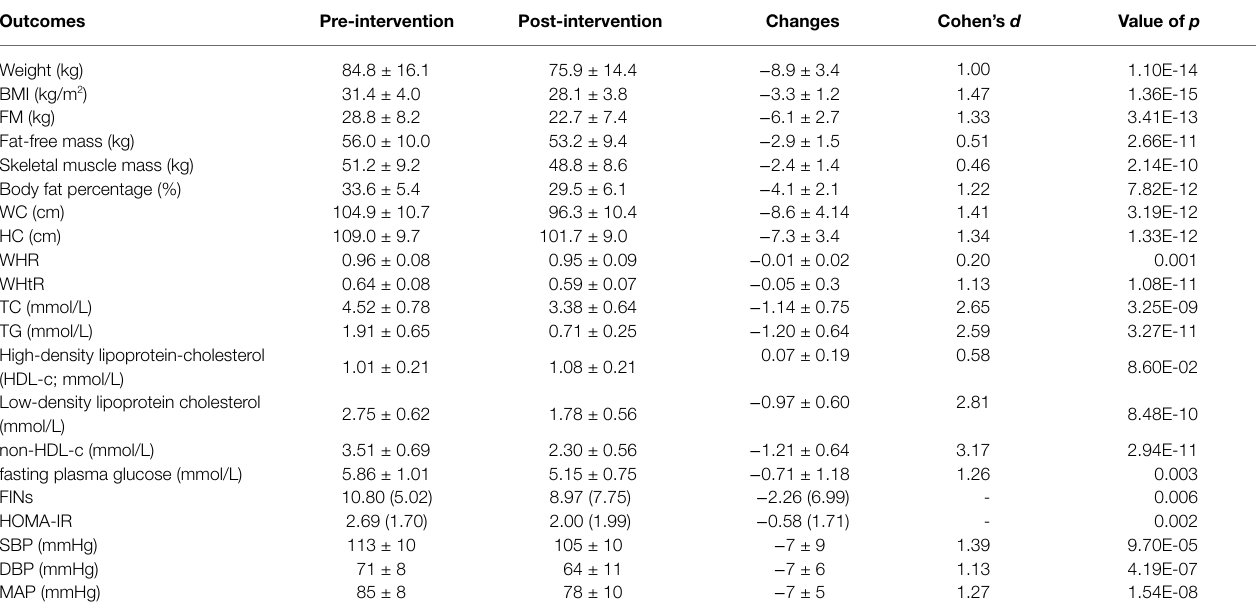
TABLE 2 | Changes in clinical characteristics and cardiometabolic risk factors in children with metabolic syndrome.